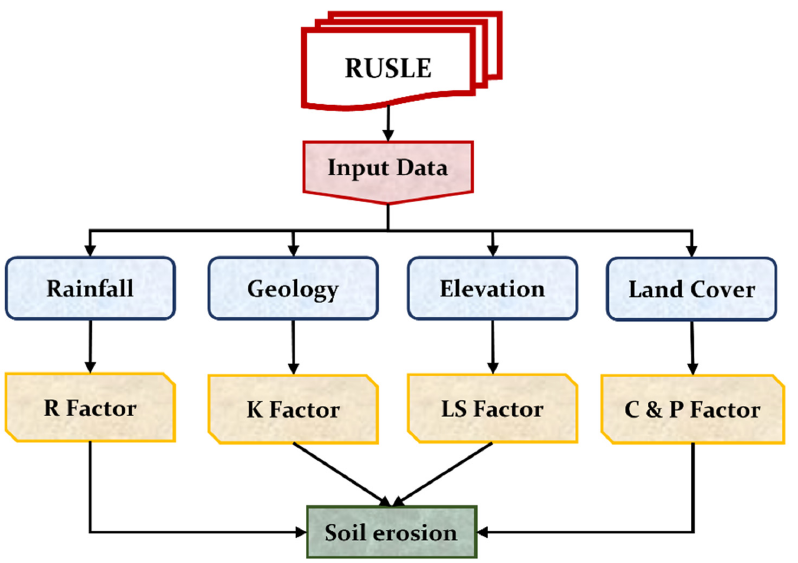
Figure 7. Flowchart of the RUSLE methodology applied in soil erosion calculation with an emphasis on the LS factor.